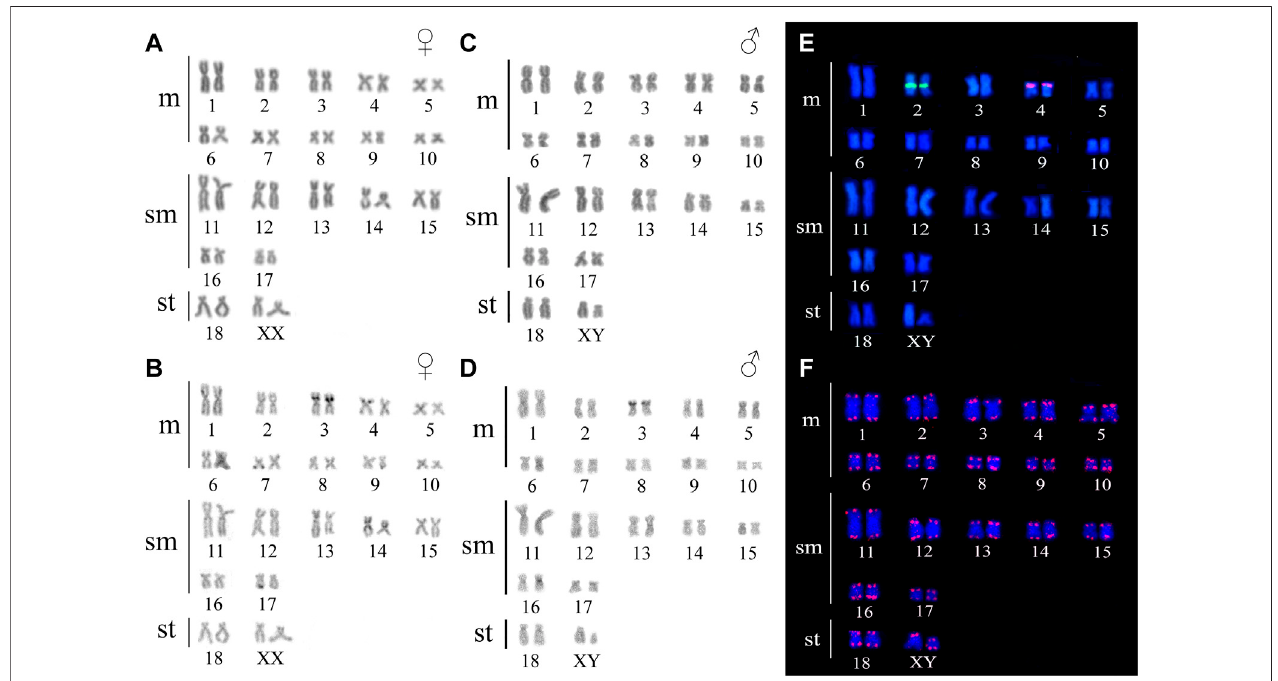
FIGURE2| KaryotypeofAncistrussp.1.In (A,B) malekaryotypestainedwithGiemsaandC-banding,respectively;in (C,D) femalekaryotypestainedwithGiemsa and C-banding, respectively; in (E) in situ localization of 18S rDNA (green) and 5S rDNA (red) sequences; in (F) in situ localization of telomeric sequences. The probes were labeled with FITC (green) and Cy3 (red), the chromosomes were counterstained with DAPI